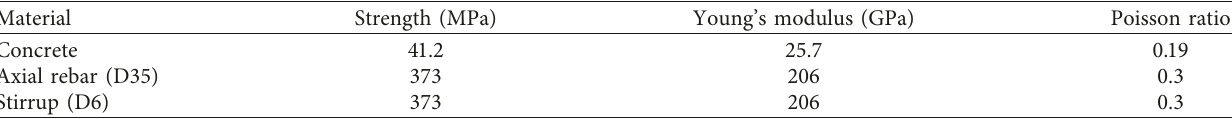
Figure 3: Stress-strain relation of materials. (a) Main and shear rebars. (b) Concrete. Table 4: Material information of RC beam.